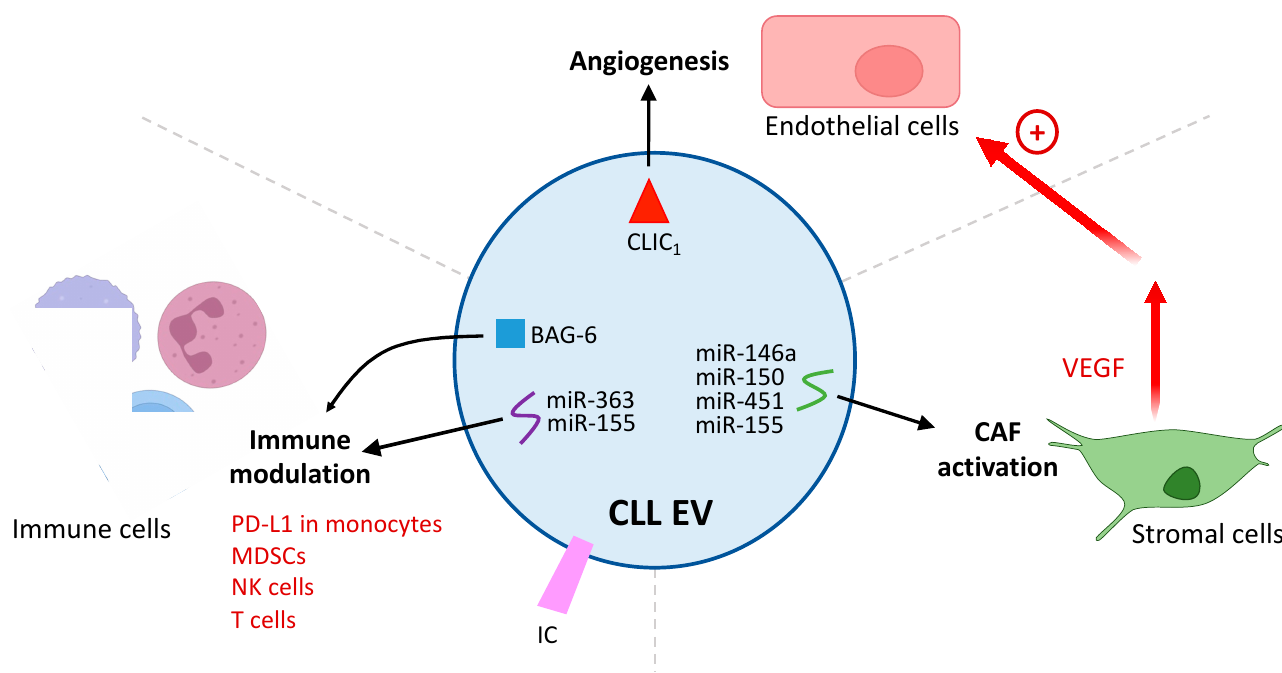
Figure 2. Influence of CLL EVs on TME. CLL EVs have the ability to influence the different cells comprising the TME through the delivery of their cargo to recipient cells, leading to a modulation of TME cell signaling in favor of the tumor. This includes the activation of stromal cells into CAFs (cancer-associated fibroblasts), increased angiogenesis in endothelial cells, and the modulation of the antitumor immune response (see text for details) (BAG6—BCL2-associated athanogene 6; CLIC1—chloride intracellular channel 1; IC—immunological checkpoint; MDSC—myeloid-derived suppressor cell; NK—natural killer; PD-L1—programmed death ligand 1; TME—tumor microenvironment; VEGF—vascular endothelial growth factor).